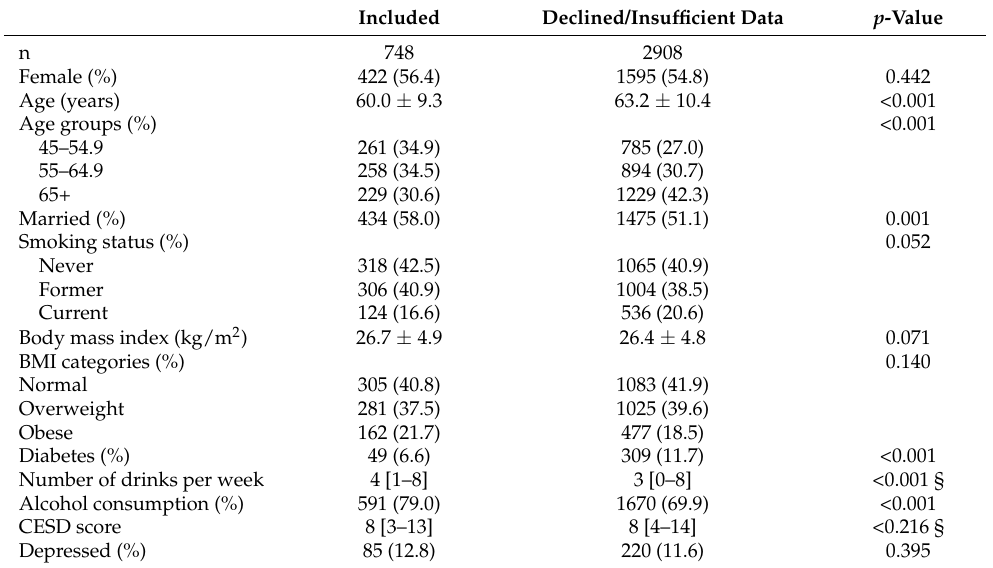
Table 1. Characteristics of included and excluded participants, CoLaus|PsyCoLaus study, Lausanne, Switzerland, 2015 – 2017.